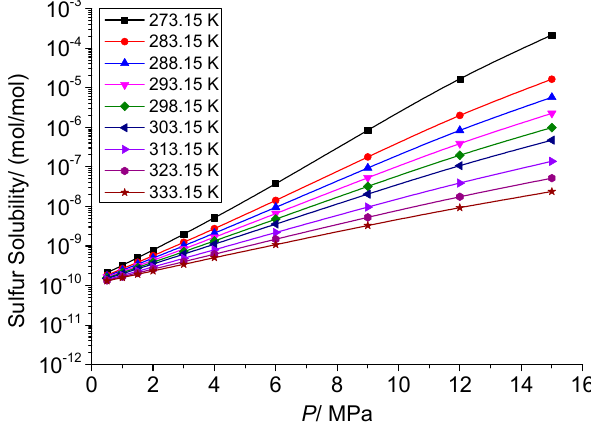
Figure 10. Chemical solubility curve of elemental sulfur in acid gas 3 with pressure.